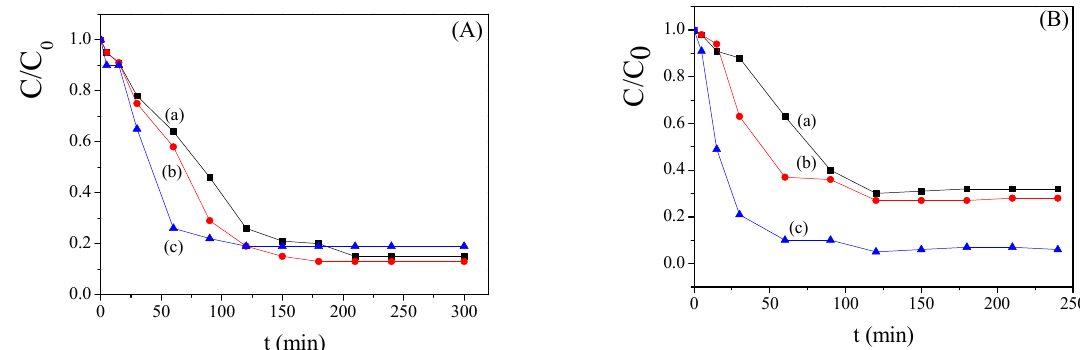
Figure 8. Relative PY concentration vs. reaction time at different temperatures for FeCu-NaY ( A ) and CuFe-NaY ( B ): (a) 40 °C; (b) 45 °C and (c) 50 °C. Other reaction conditions: 50 mg of catalyst, V PY = 250 mL, C 0 = 30 ppm, initial pH = 3.00, C H2O2 = 12 mM. Table 3. Catalytic results for PY degradation on the bimetallic catalysts. Reaction conditions: 50 mg of catalyst, V PY = 250